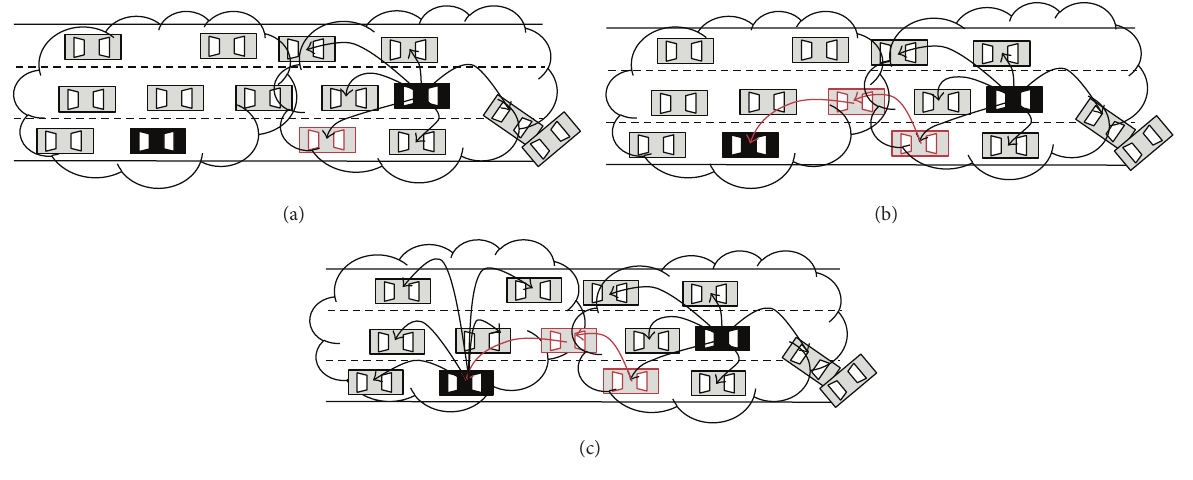
Figure 5: Packet